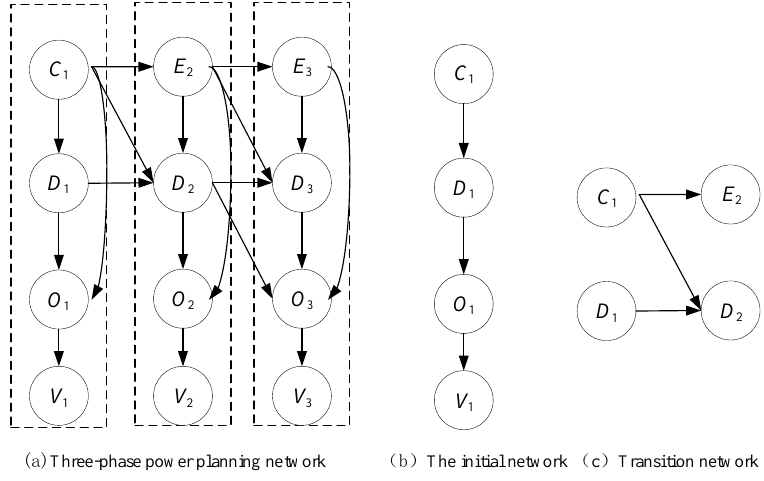
Figure 5. Three-phase generation expansion planning network representation.